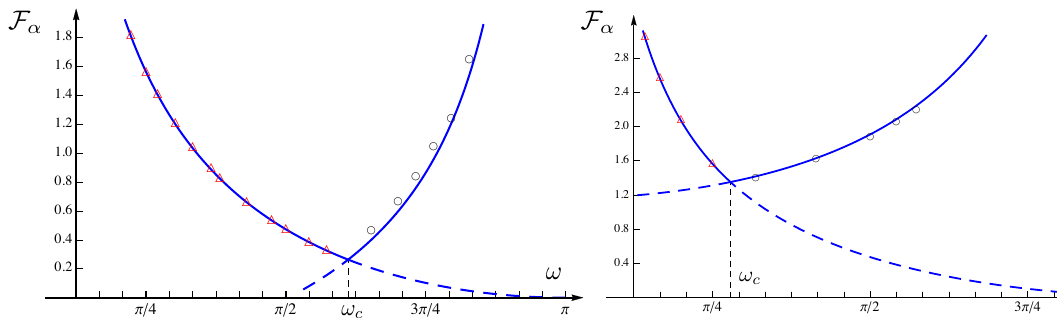
Figure 17 . The corner function (7.2) for symmetric con(cid:12)gurations of the in(cid:12)nite wedge (i.e. ~ (cid:13) = (cid:13) ). The slope (cid:11) of Q is di(cid:11)erent in the two panels: (cid:11) = (cid:25)= 2 : 3 (left) and (cid:11) = 2 (cid:25)= 3 (right). The solid blue line is obtained from the analytic expression (7.2). The data points have been found by constructing minimal surfaces with Surface Evolver anchored to single drop domains whose opening angle of the corner is ! . The minimal surfaces corresponding to the empty black circles are connected to Q (see e.g. (cid:12)gure 16), while the ones corresponding to the empty red triangles are disconnected from Q . The critical value ! c is de(cid:12)ned by (7.3). Notice that ! c > (cid:25)= 2 when (cid:11) < (cid:25)= 2 and ! c < (cid:25)= 2 when (cid:11) > (cid:25)=